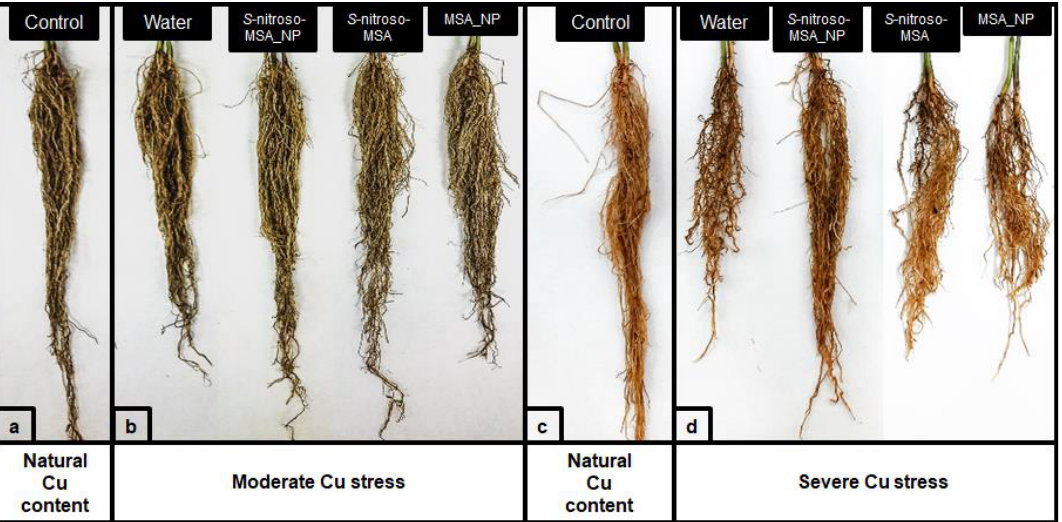
Figure 2. Visual aspect of the roots from soybean plants cultivated in soil with natural copper (Cu) content ( a ) and Cu supplementation to 164 mg kg −1 ( b ) in experiment 1. Visual aspect of the roots from the soybean plants cultivated in soil with a natural Cu content ( c ) and Cu supplementation of 244 mg kg −1 ( d ) in experiment 2. Control = treatment with distilled water; water = treatment with distilled water after the Cu addition; S-nitroso-MSA_NP = treatment with a nanoencapsulated NO donor (S-nitroso-mercaptosuccinic acid) at 1 mM; S-nitroso-MSA = treatment with a NO donor (S-nitroso-mercaptosuccinic acid) in the free form at 1 mM; MSA_NP = treatment with nanoparticles containing the non-nitrosated MSA at 1 mM.